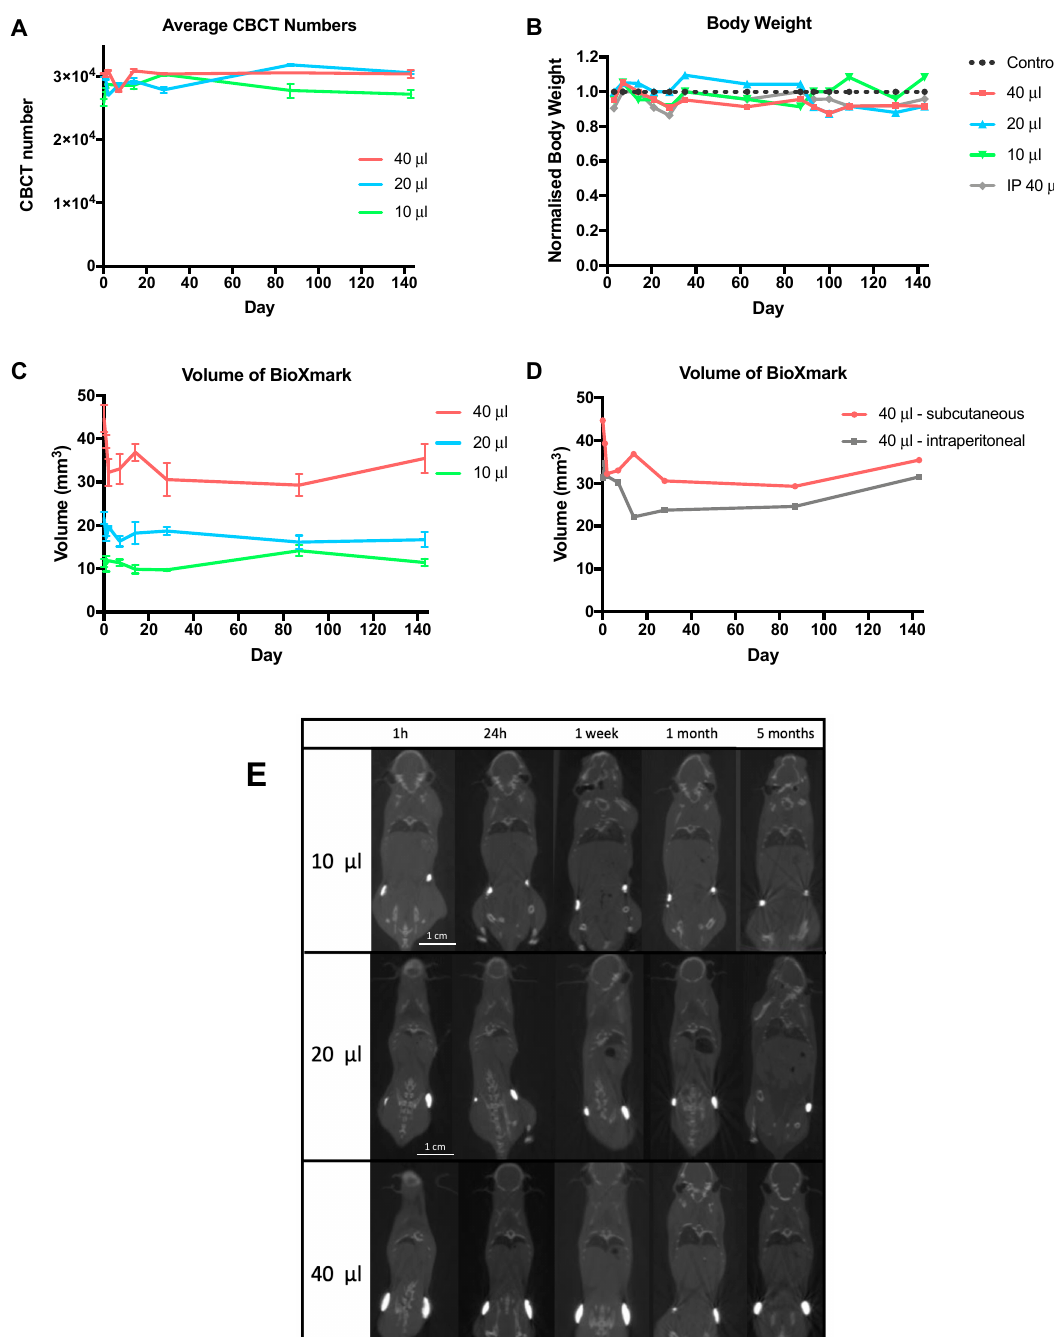
Figure 3. Evaluation of BioXmark ® in vivo over a 5-month period. ( A ) CBCT visibility of different volumes of BioXmark ® (10, 20 and 40 µL) subcutaneously injected were assessed over a 5-month period along with corresponding marker volumes (average ± SEM, n = 2) ( C ). ( D ) Comparison of marker volumes after a 40 µL subcutaneous or intraperitoneal injection. ( B ) Health and wellbeing of mice was monitored through weight measurements. No changes to marker shape and movement were detected via representative coronal CBCT scans of BioXmark ® injected subcutaneously ( E ).